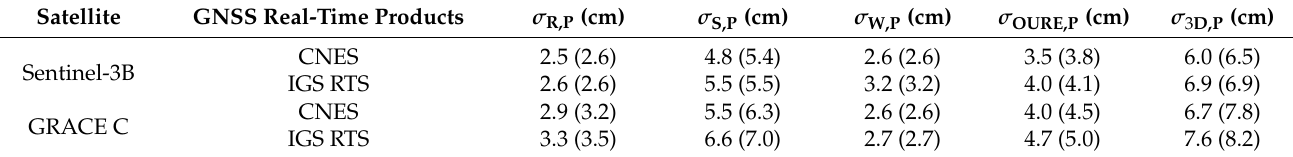
Table 7. Averaged RMS of the predicted orbital errors at 6–11 min and the corresponding OUREs for Sentinel-3B and GRACE C using different real-time GNSS products. The results without outlier exclusions are given in